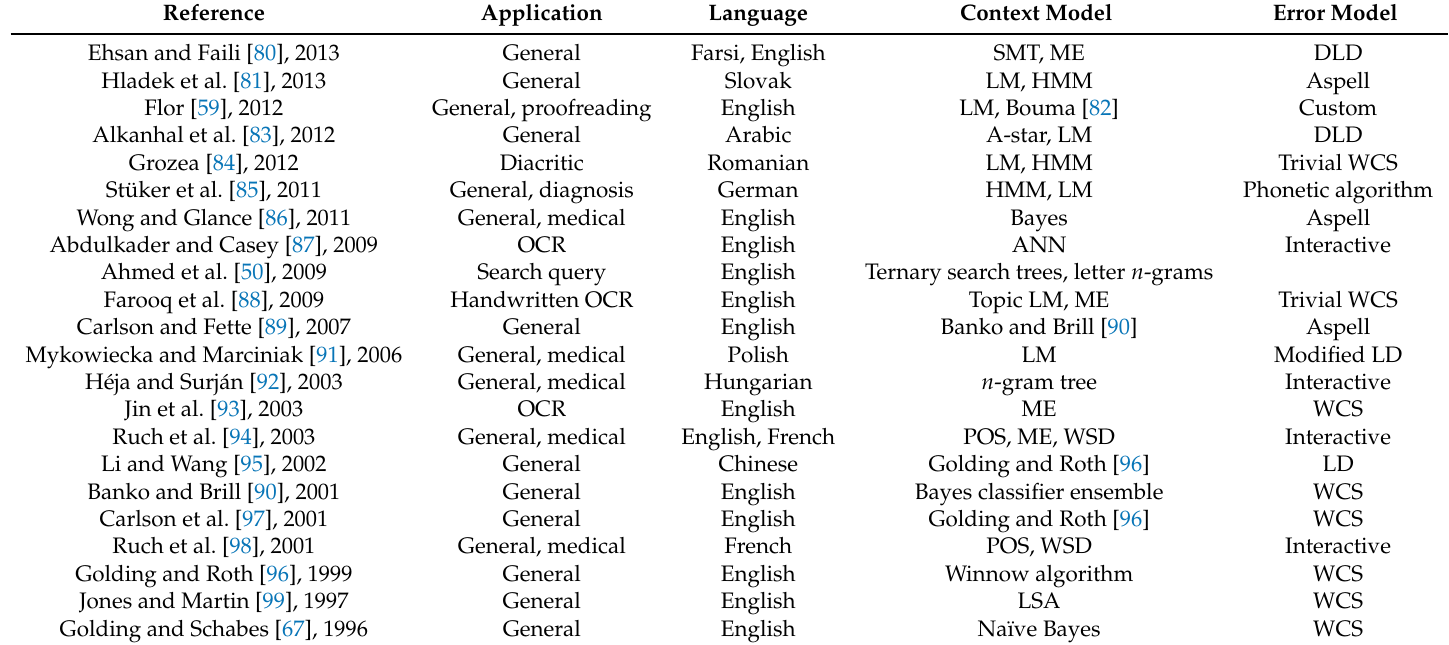
Table 4. spelling correction systems with learning of context model—part